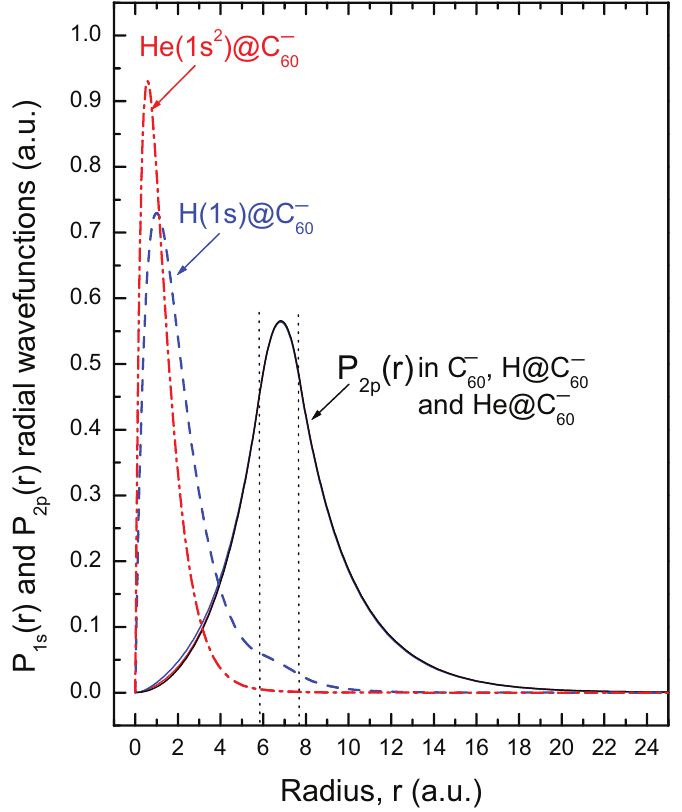
( r ) and P He ( r ) radial functions of the encapsulated H and He atoms, as well Figure 1. Calculated P H 1 s 1 s as the P 2 p ( r ) radial function of the attached 2 p -electron in the C − fullerene anions, as marked. Note: the P 2 p ( r ) functions in these anions are practically indistinguishable from one another. Vertical dotted lines mark the boundaries of the C 60